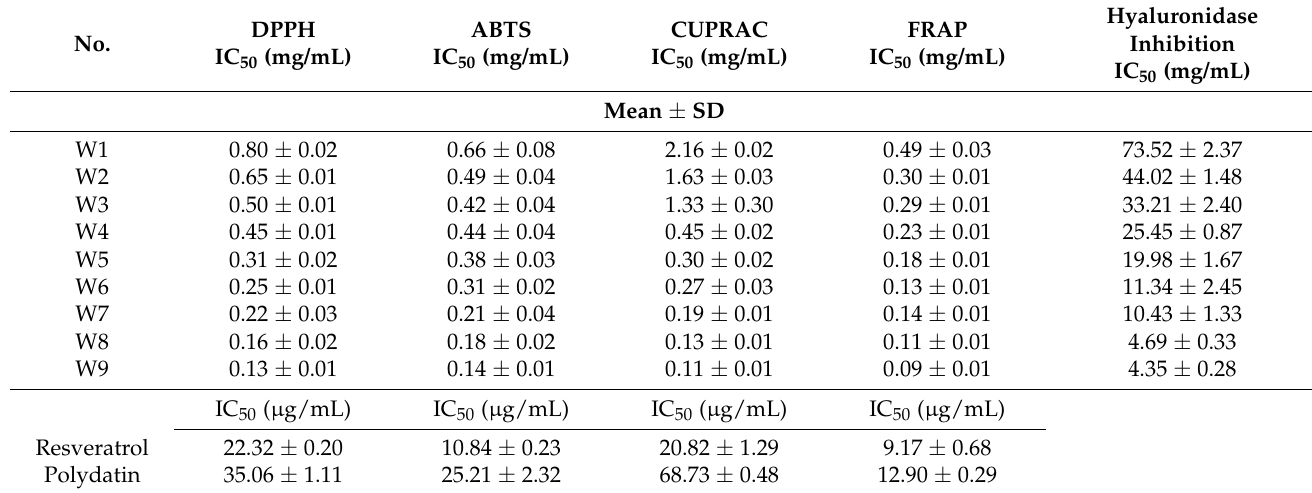
Table 4. Antioxidant and Anti-Hialuronidase